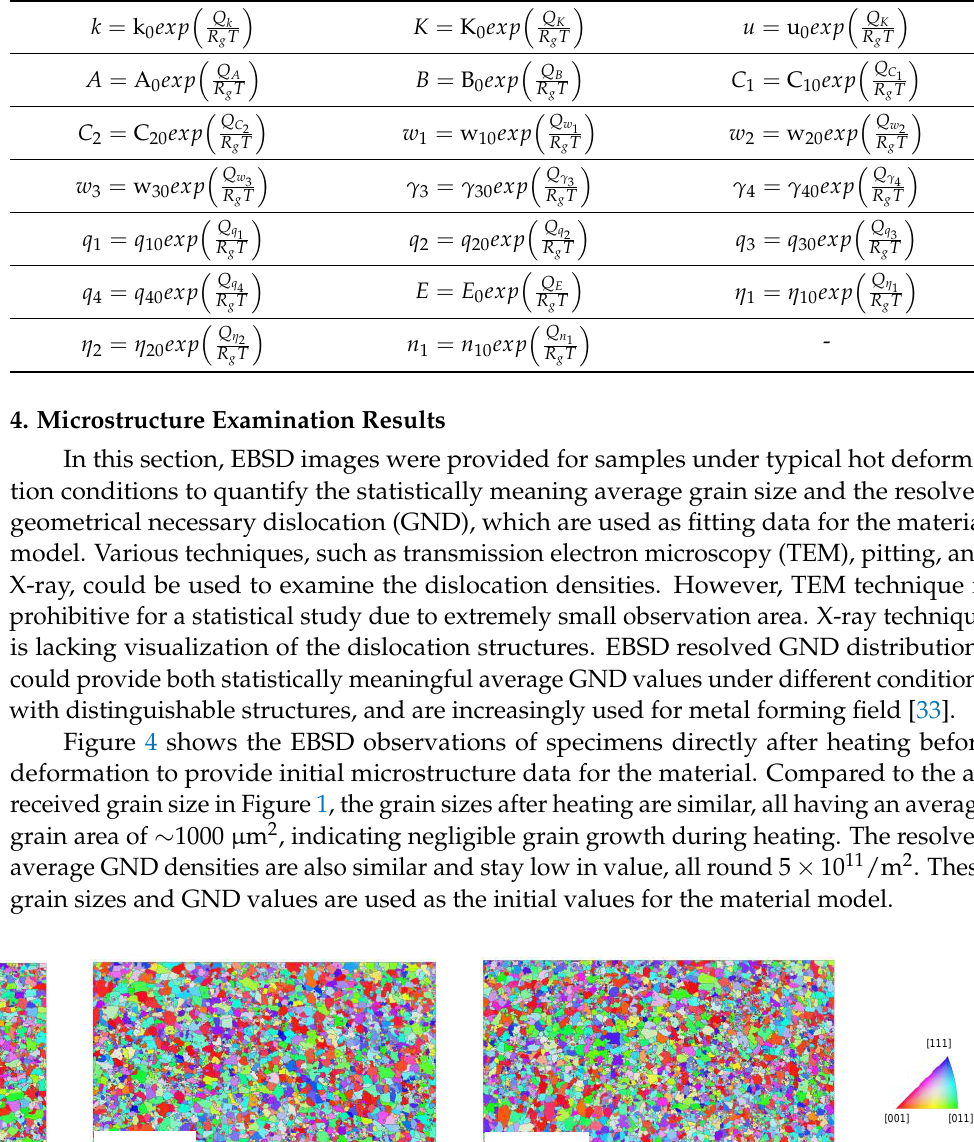
Table 3. The equation set of temperature-dependent material constants.